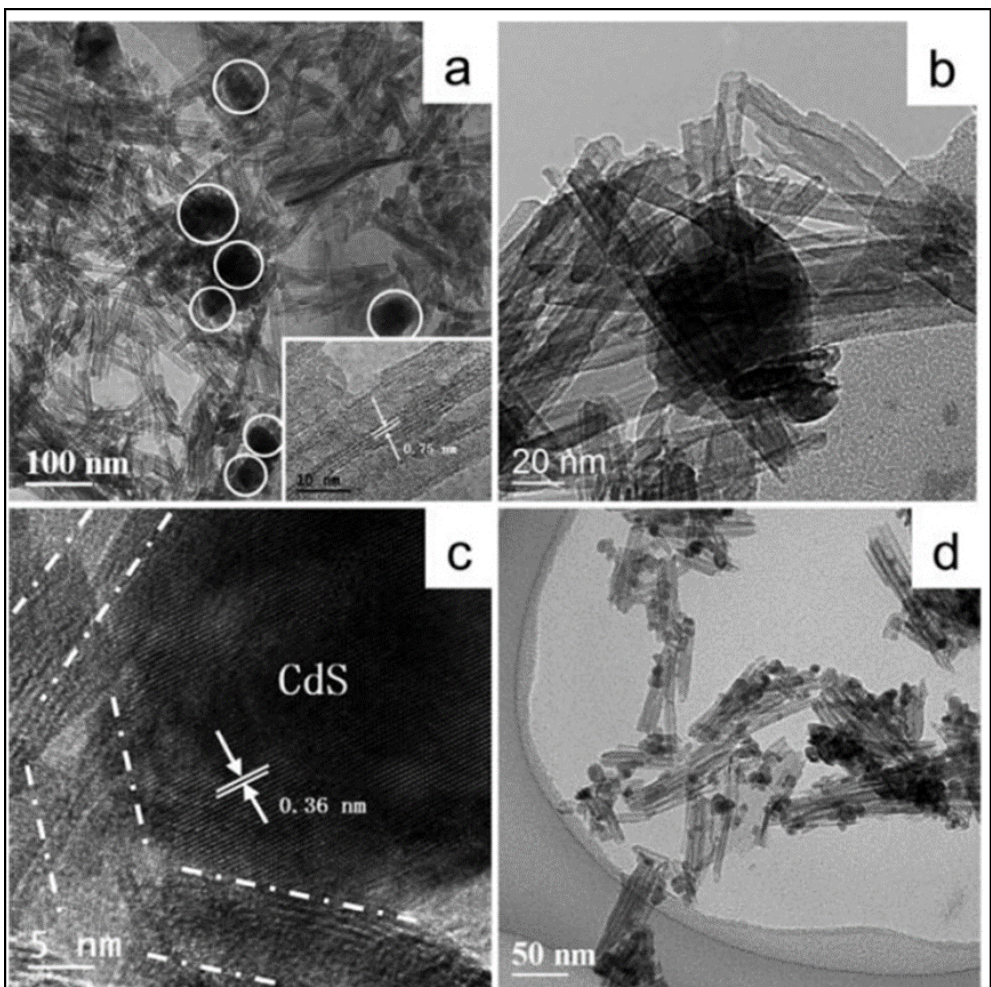
Figure 22. TEM images of various samples: ( a , b ) CdS/TNTs; ( c ) the multipoint contacts between the CdS nanoparticles and TNTs in CdS/TNTs; ( d ) CdS@TNTs. Reproduced with permission from reference [140].